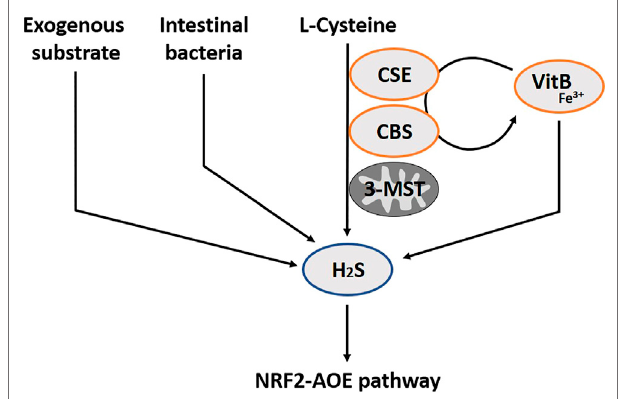
FIGURE 3 | The hydrogen sulfide pathway (H 2 S) including involved substrates and enzymes. H 2 S is produced through enzymatic pathways of CSE, CBS and 3-MST. In addition, intestinal bacteria can also secrete H 2 S, and several exogenous substrates exist. Vitamin B6 and iron are also required for the non-enzymatic synthesis of H 2 S in blood. H 2 S exerts antioxidant effects through several mechanisms, such as increasing expression of AOE, by activating the transcription factor NRF2. CSE, Cystathionine gamma-lyase; CBS, Cystathionine beta-synthase; 3-MST, 3- mercatopyruvate; VitB, Vitamin B6; AOE, Antioxidant enzymes; NRF2, Nuclear factor erythroid-derived 2-like